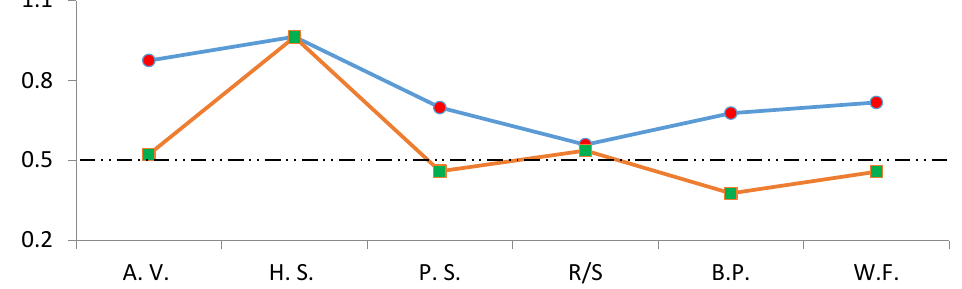
Figure 8. Original and shuffled series’ scaling exponent test results.